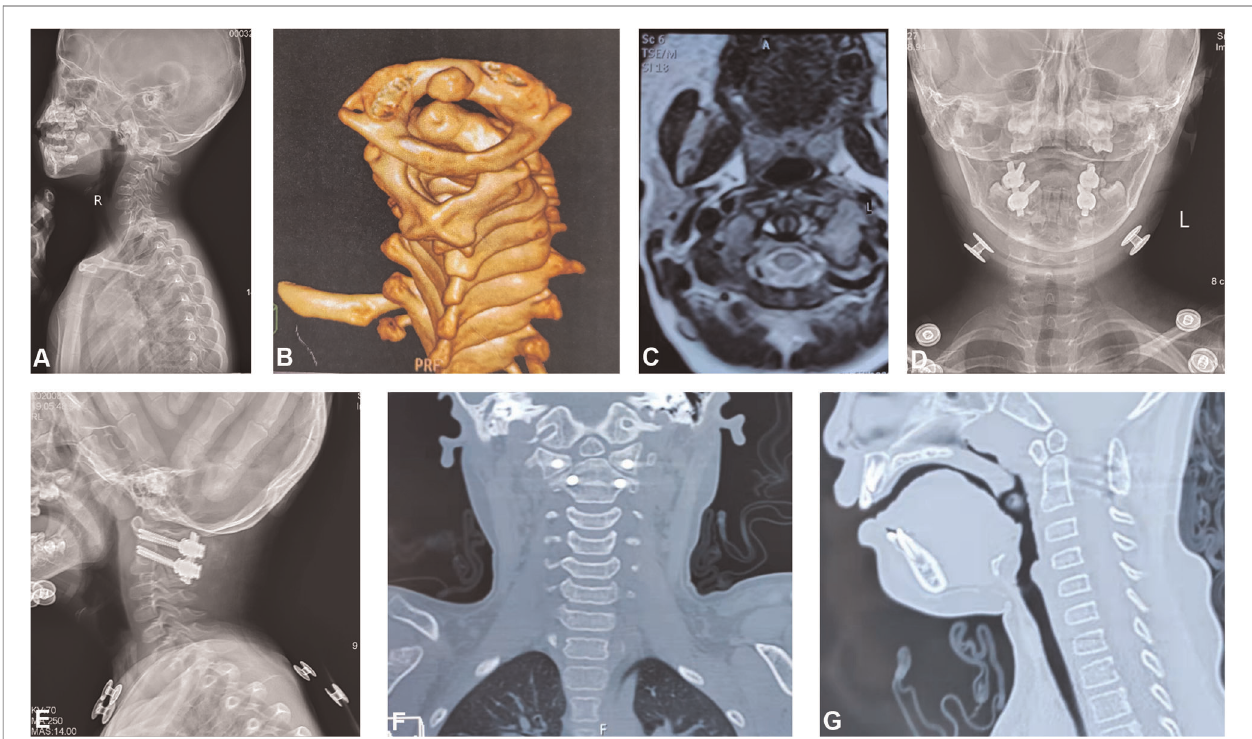
FIGURE 2 | Case 4. A 4-year-old female child with DS, atlantoaxial dislocation with OsO. ( A ) Dynamic X-ray showed that the ADI increased signi fi cantly, and a shift of the atlas anterior and lower to the axis. ( B ) Three-dimensional reconstruction shows atlantoaxial dislocation with OsO. ( C ) MRI showed no compression of the upper cervical spinal cord. ( D and E ) Postoperative X-ray fi lms showed atlantoaxial screw rod fi xation. ( F and G ) At postoperative 1 year, atlantoaxial CT showed that the posterior atlantoaxial fusion was good, the internal fi xation position was satisfactory, and there was no spinal canal